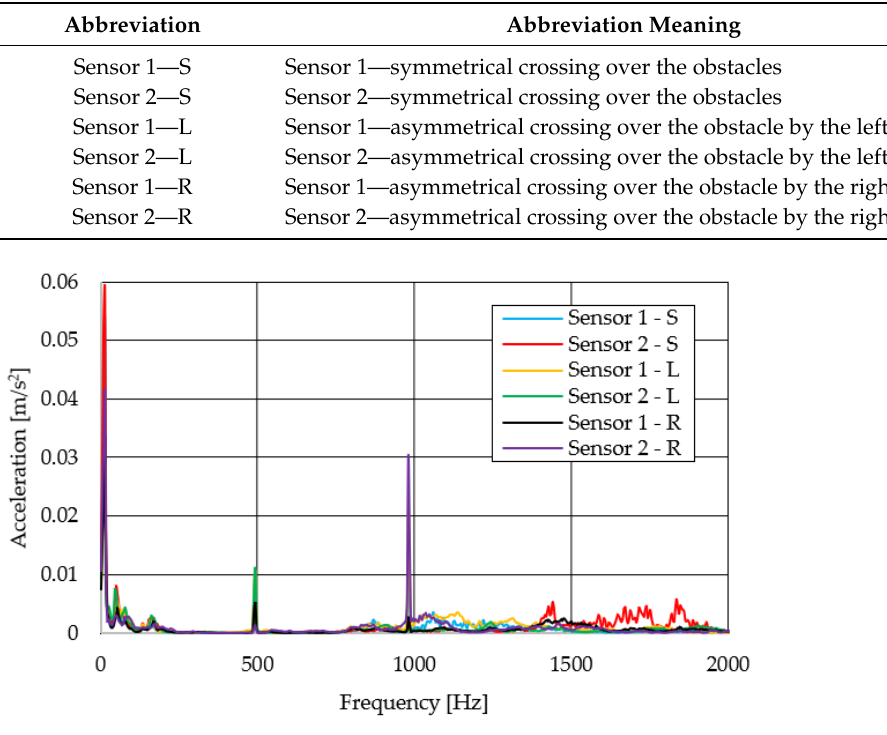
Figure 25. Comparison of the frequency waveforms in the z -axis during asymmetrical crossing over the obstacle by the right wheel.